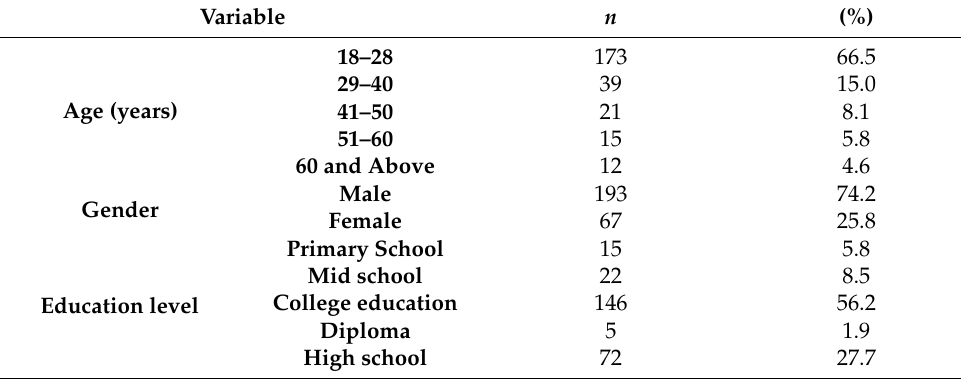
Table 1. Demographic details of study participants ( n =